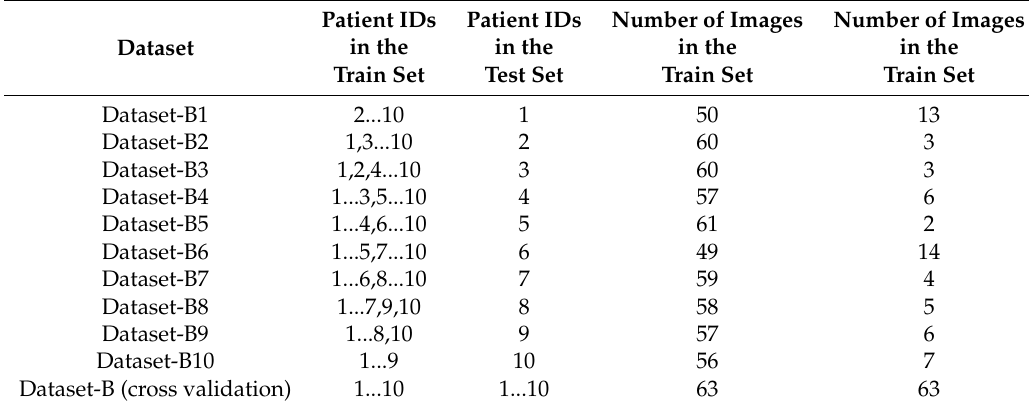
Table 2. Composition of Dataset-B